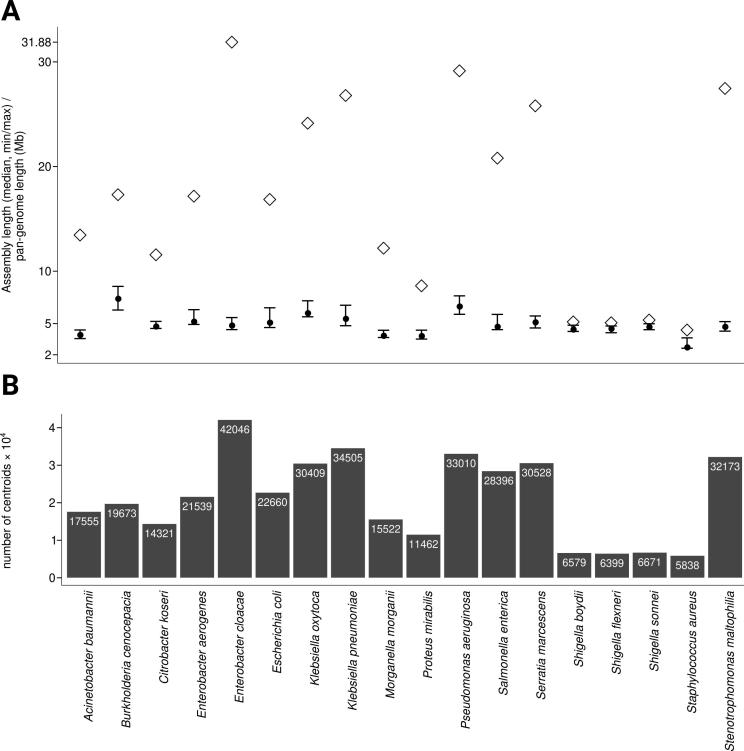
Assembly length and pan-genome size A. Median assembly length (solid black points), minimal and maximal assembly length (error bars), and pan-genome size (cumulative length over all centroids, diamond-shaped points) in Mb. B. Number of centroids per pan-genome.